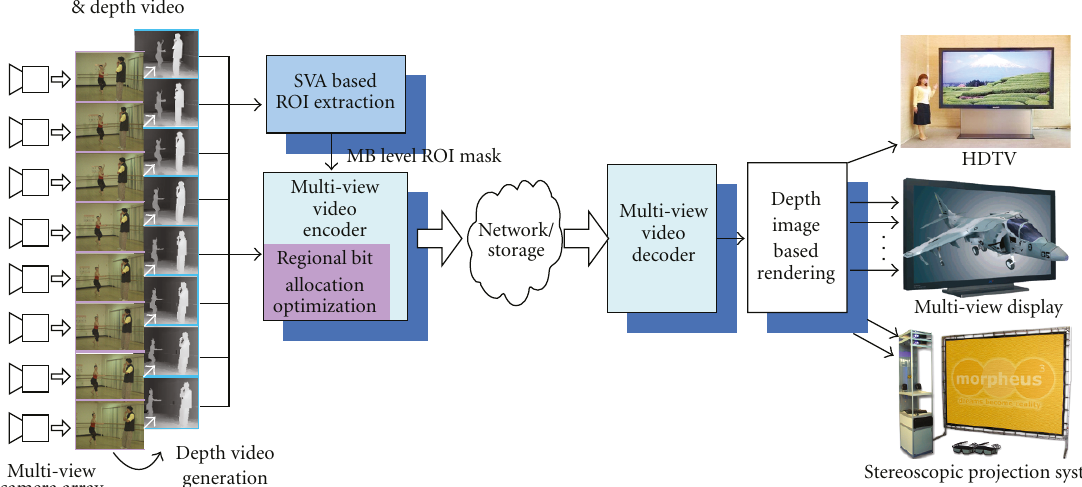
Figure 1: Framework of multiview video system using regional bit allocation optimization.